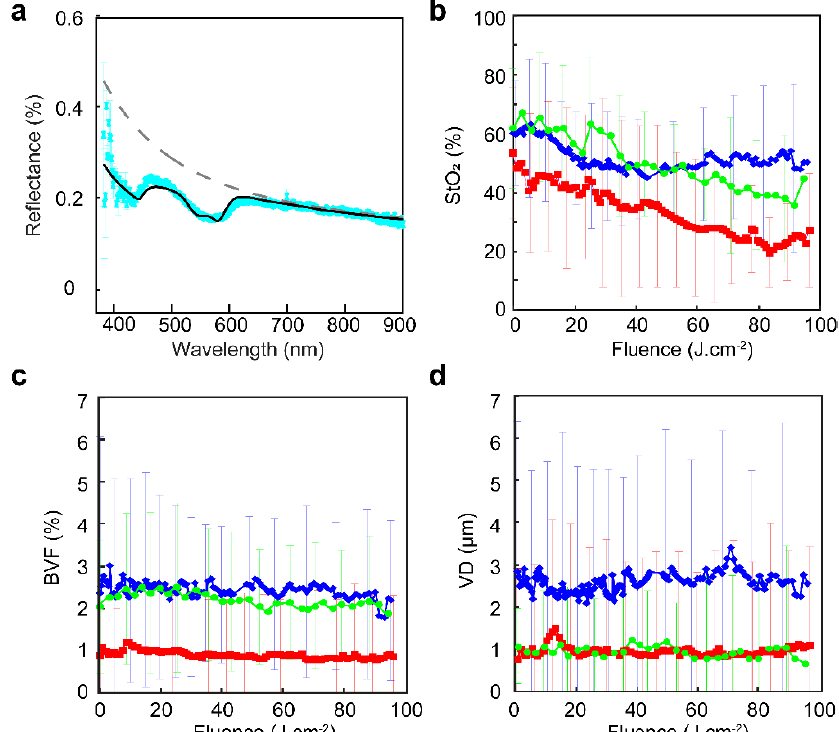
Figure 5. Reflectance measurements during PDT using di ff erent fluence rates. ( a ) Example of a collected reflectance spectrum recorded pre illumination (cyan), fitted spectrum (black solid line), and scattering background (dashed line) to determine StO 2 , BVF, and VD. ( b ) Weighted mean StO 2 determined during PDT at 20 mW · cm − 2 (blue diamonds), 50 mW · cm − 2 (red squares), and 150 mW · cm − 2 (green circles). ( c ) Weighted mean blood volume fraction (BVF) determined during PDT at 20 mW · cm − 2 (blue diamonds), 50 mW · cm − 2 (red squares), and 150 mW · cm − 2 (green circles). ( d ) Weighted mean vessel diameter (VD) determined during PDT at 20 mW · cm − 2 (blue diamonds), 50 mW · cm − 2 (red squares), and 150 mW · cm − 2 (green circles). No significant di ff erences in vessel density and blood volume fraction were observed between tumors in each group.